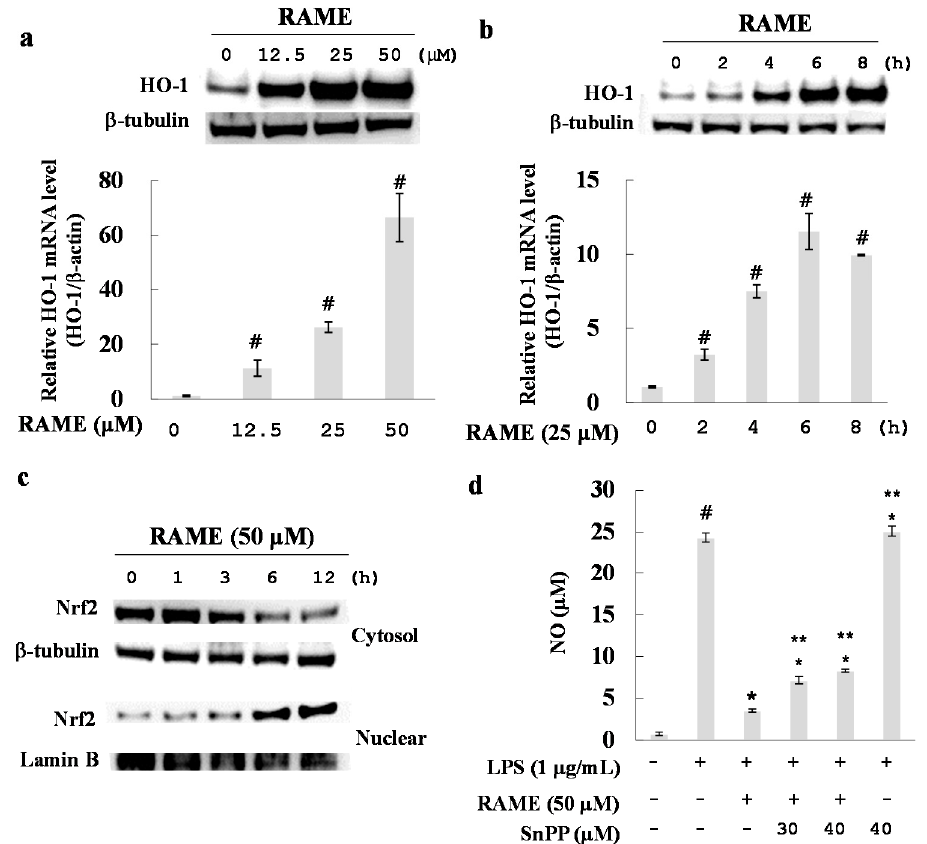
Figure 6. Effects of RAME on HO-1 expression. ( a ) RAW 264.7 cells were incubated with various concentrations of RAME for 6 h. The HO-1 mRNA expression level was determined by quantitative real-time PCR. HO-1 protein expression levels were measured by western blot analysis. # p < 0.05 vs. control group; ( b ) RAW 264.7 cells were treated with 25 µ M RAME for 0, 2, 4, 6 and 8 h. Total RNA was isolated and used to measure HO-1 mRNA expression levels by quantitative real-time PCR. # p < 0.05 vs. control group; ( c ) Cytosolic and nuclear protein fractions were extracted after treatment with RAME (50 µ M) for 0, 1, 3, 6 and 12 h. Protein levels were normalized to those of β -tubulin and lamin B; ( d ) RAW 264.7 cells were treated with either RAME or RAME plus SnPP, an HO-1 inhibitor, for 2 h prior to incubation with LPS (1 µ g/mL) for 18 h. # p < 0.05 vs. control group, * p < 0.05 vs. LPS-treated group and ** p < 0.05 vs. LPS + RAME group.